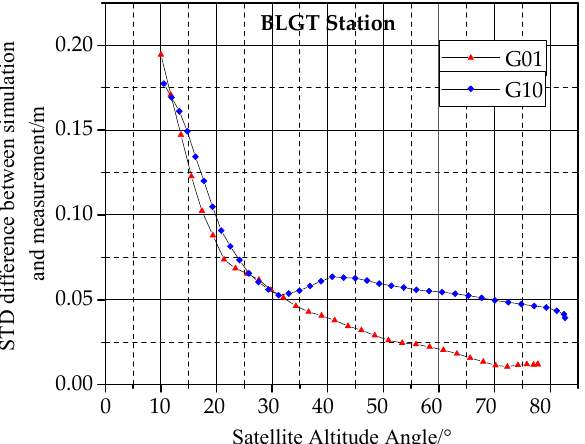
Figure 4. STD di ff erence between simulation and measurement of G01 and G10 satellite at BLGT station.